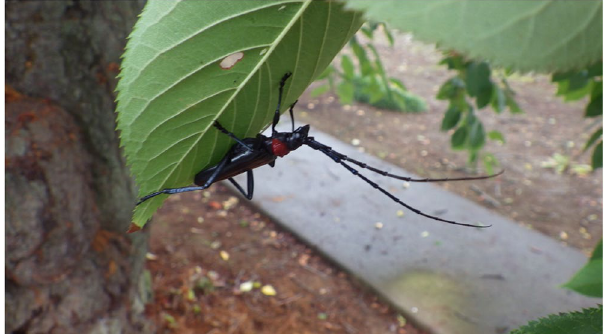
Figure 1. Male Aromia bungii on a cherry leaf (Gunma Prefecture, Japan, July 2016).